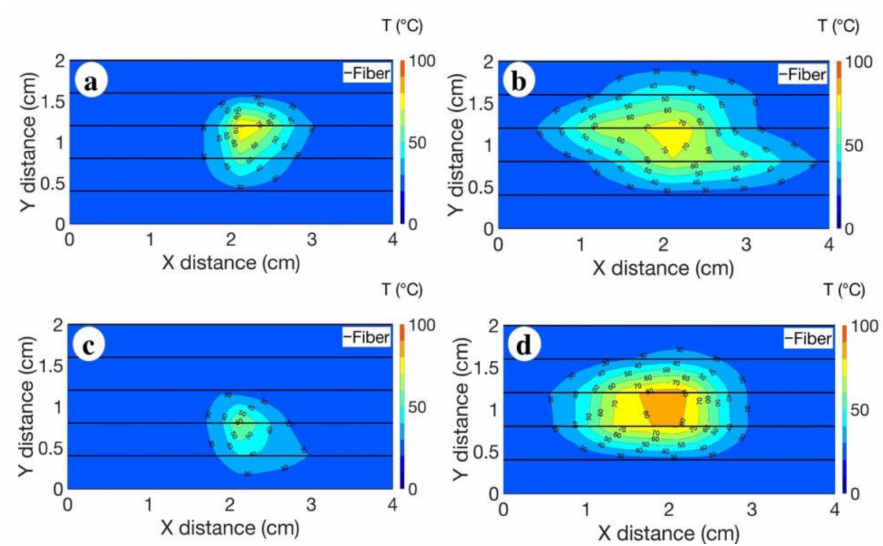
Figure 6. Thermal maps showing the evaluated heating effects in four cases: ( a ) pristine liver tissue with the vessel located in a parallel position; ( b ) the tissue introduced with the agarose gel, with the location of the vessel in parallel to the optical fibers; ( c ) pristine tissue with the vessel located in a perpendicular direction; ( d ) the tissue introduced with the agarose gel, with the vessel positioned in a perpendicular direction. The charts report the isothermal curves, sampled at each 10 ◦ C temperature